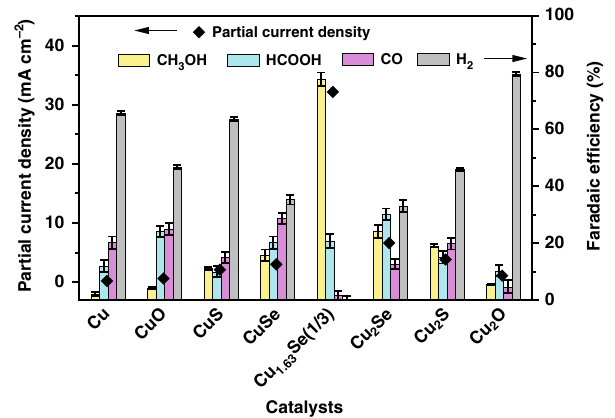
Fig. 3 Catalytic activity of various Cu-based catalysts. Partial current density and FE of methanol over various catalysts at − 2.1 V vs. Ag/Ag + . All data are presented as mean ± s.